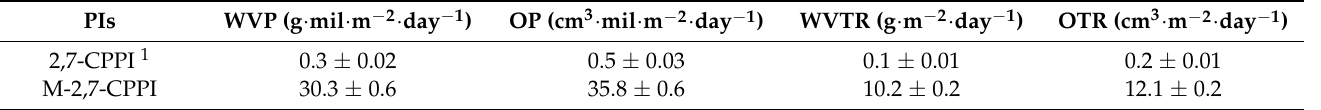
Table 2. Barrier properties M-2,7-CPPI and 2,7-CPPI films.